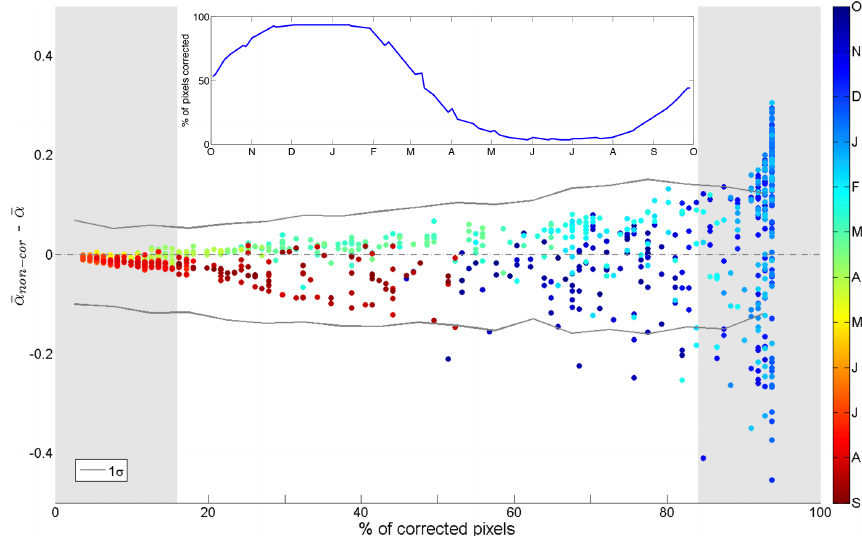
Figure 9. Impact of the ratio of corrected pixels toward the difference between non-corrected and glacier-wide albedo for Argentière Glacier. Each point corresponds to one acquisition and the 16 years are therefore displayed on this graph. Colour scale gives some indication of the date of the acquired image. Grey shaded areas correspond to ratios of corrected pixels for which α non-cor − α has low statistical robustness (refer to the main text). Thin grey lines represent 1 σ SD of α , averaged by classes of 5% corrected pixels. The inner graph illustrates the amount of corrected pixel, as function of the selected